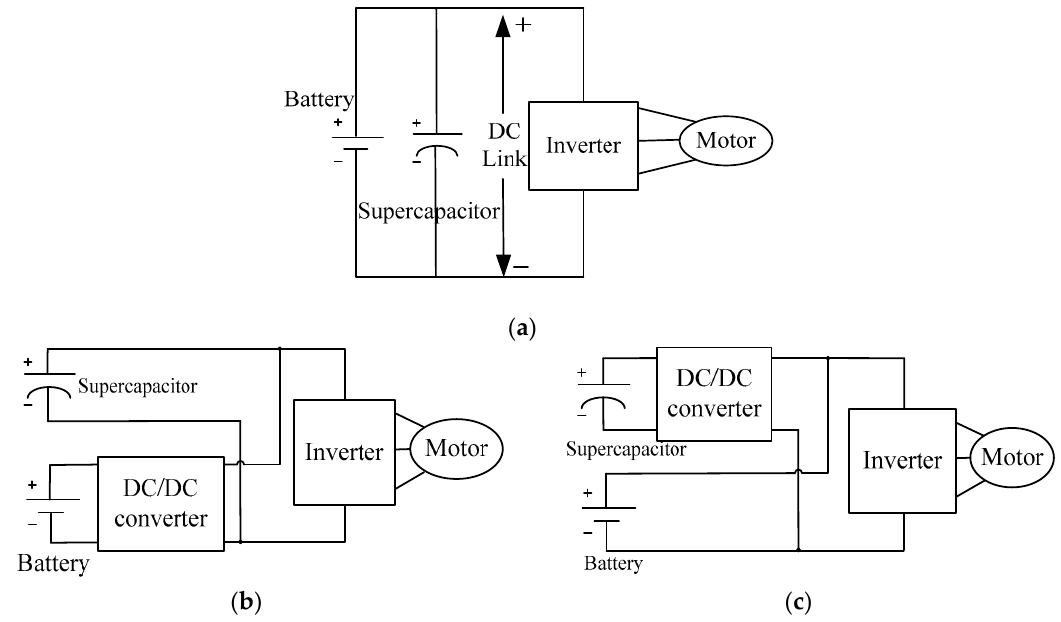
Figure 1. Different hybrid energy storage system (HESS) topologies: ( a ) passive parallel topology; ( b ) battery / supercapacitor (SC) configuration; ( c ) SC / battery configuration.